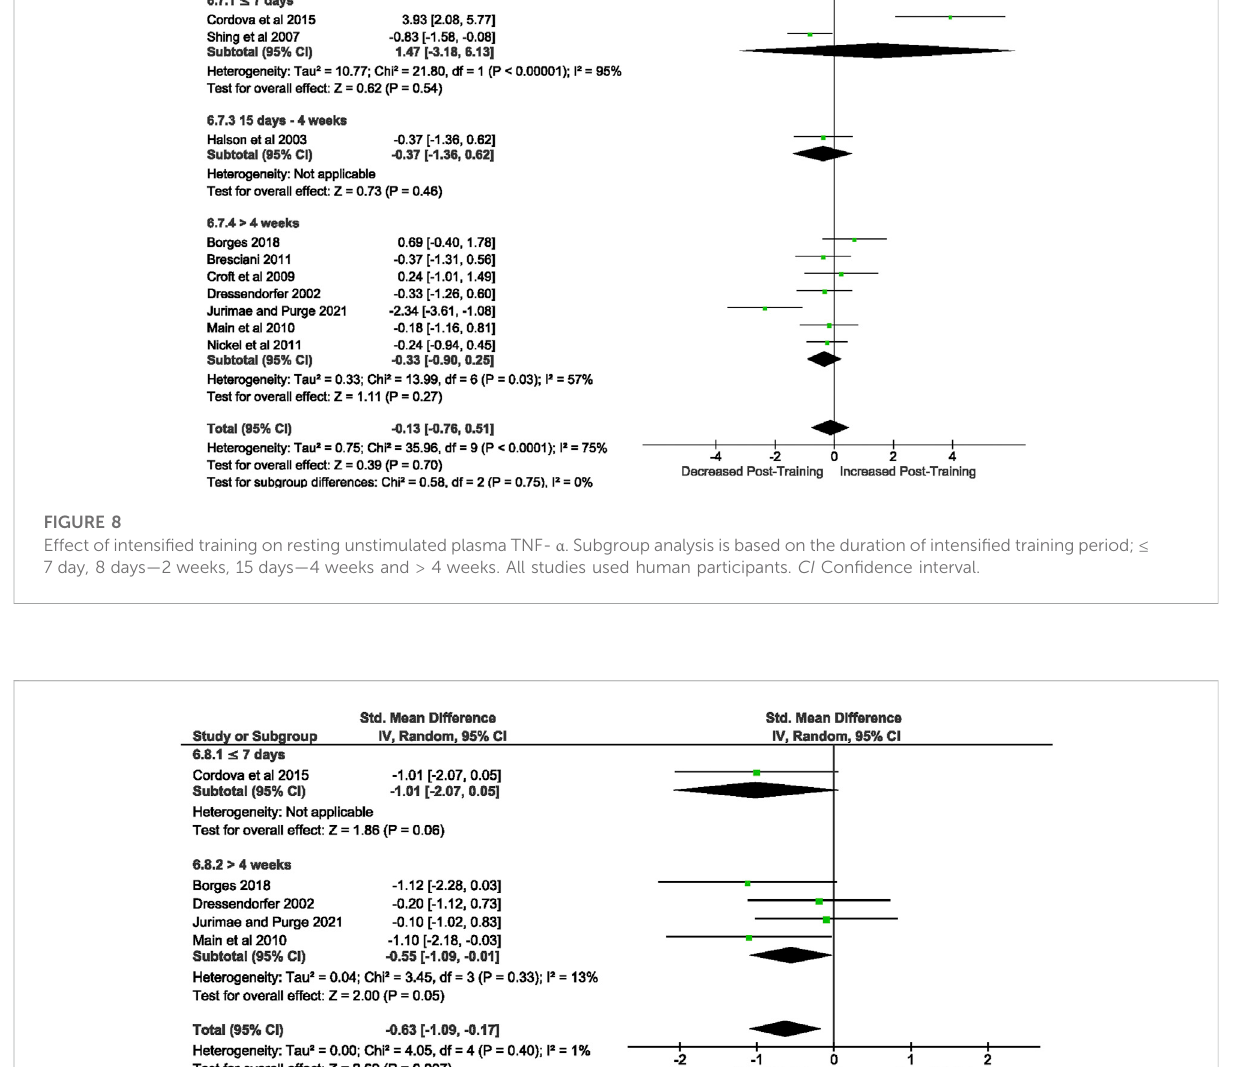
FIGURE 9 Effect of intensi fi ed training on resting unstimulated plasma IL-1 β . Subgroup analysis is based on the duration of intensi fi ed training period; ≤ 7 days, 8 days — 2 weeks, 15 days — 4 weeks and > 4 weeks. All studis used human participants. CI Con fi dence interval.